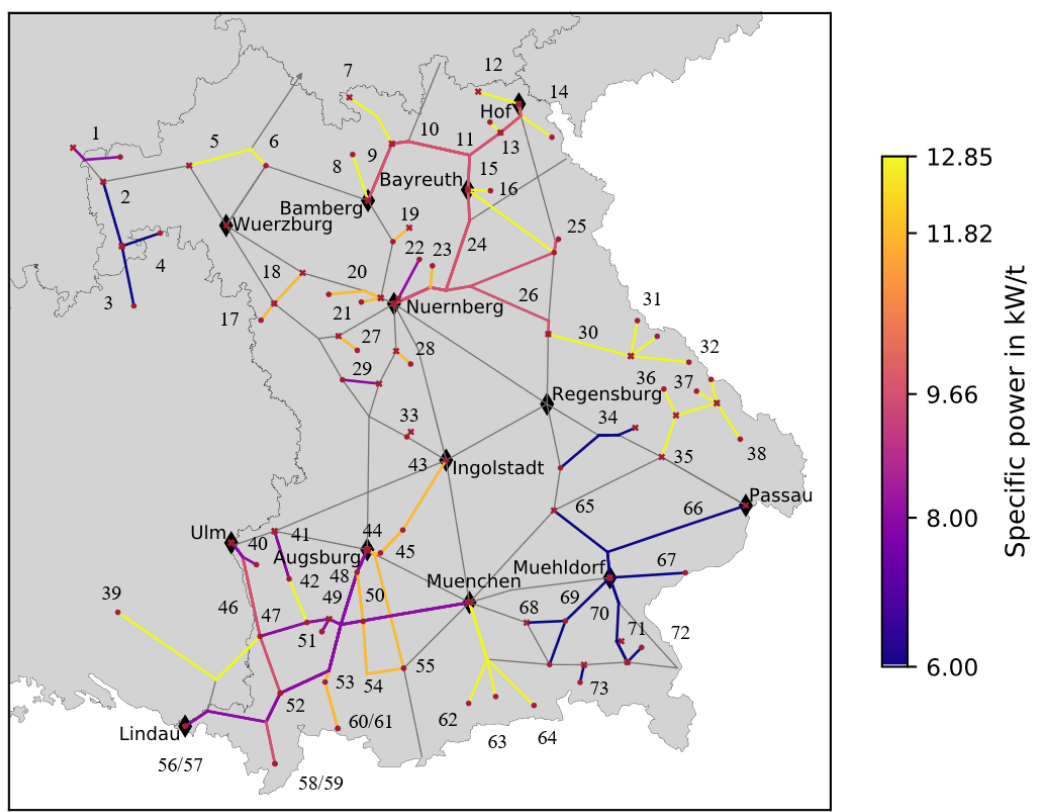
Figure 8. Figure B3: Minimum specific power requirements on current diesel